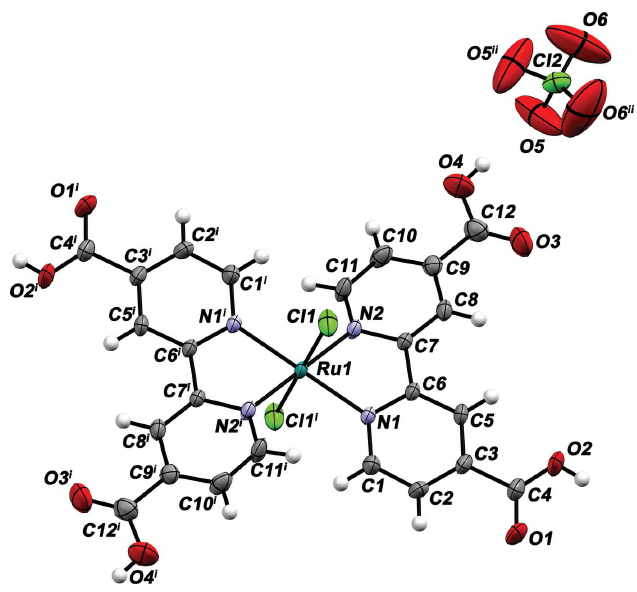
Figure 1 The structures of the molecular entities in the title compound. Displacement ellipsoids are drawn at the 50% probability level (cid:5) x , (cid:5) 1 (cid:5) y , 1 (cid:5) z ; (ii) 1 (cid:5) x , + y , 3 [symmetry codes: (i) 1 2 2